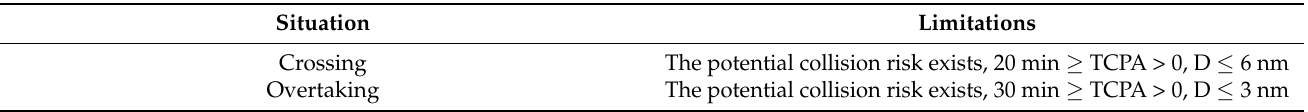
Table 1. Quantitative standards of FTCR for the crossing and overtaking situations.